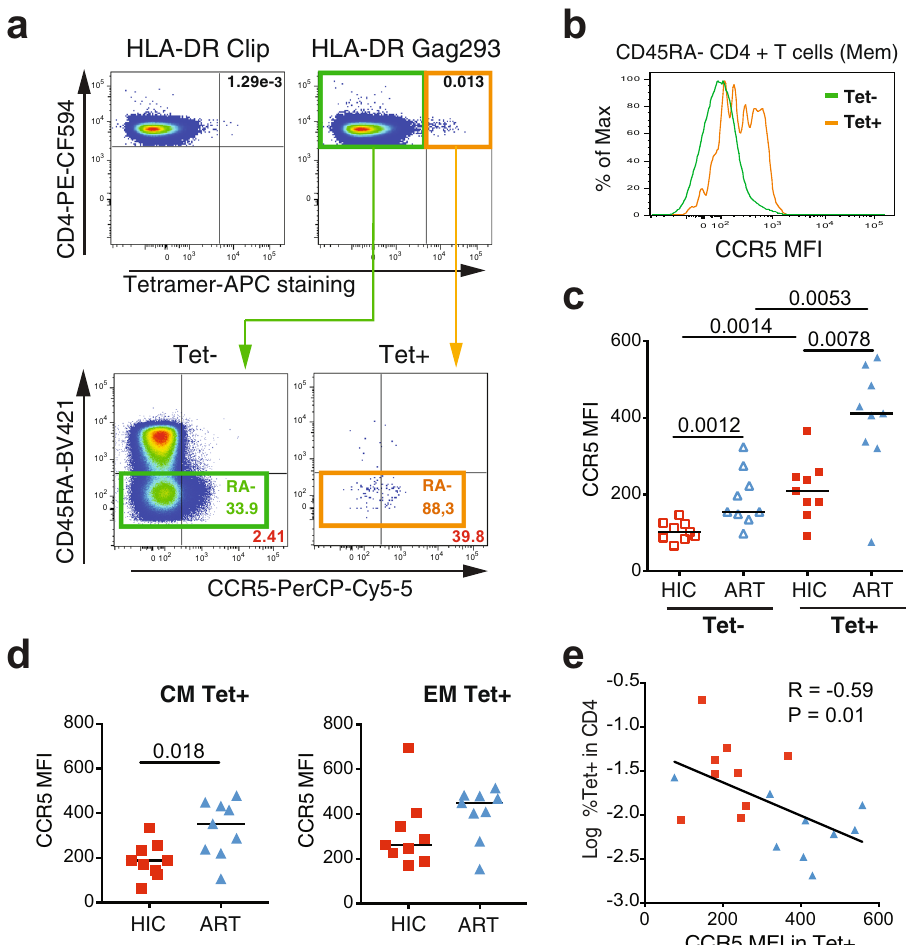
Fig. 3 Low CCR5 expression correlates with the persistence of Gag293-speci fi c CD4 + T cells. a Example of CCR5 staining in Gag293-speci fi c (Tet + ) and non-speci fi c (Tet − ) controller CD4 + T cells. b Comparison of the CCR5 MFI in the Tet + and Tet − populations shown in a , after gating in the CD45RA − memory (Mem) population. c Comparison of CCR5 MFI in the Tet + and Tet − populations of controller (HIC) and treated patient (ART) Mem CD4 + T cells. d Comparison of CCR5 expression in the central memory (CM) and effector memory (EM) subsets of Tet + cells. Signi fi cant differences between medians computed with the Mann-Whitney test are reported in c – d . e Inverse correlation between the frequency of Gag293-speci fi c Tet + cells in CD4 + T cells and CCR5 expression in Mem Tet + cells. The Spearman linear correlation coef fi cient R and the associated P -value are reported. HIC Tet + red squares; ART Tet + blue